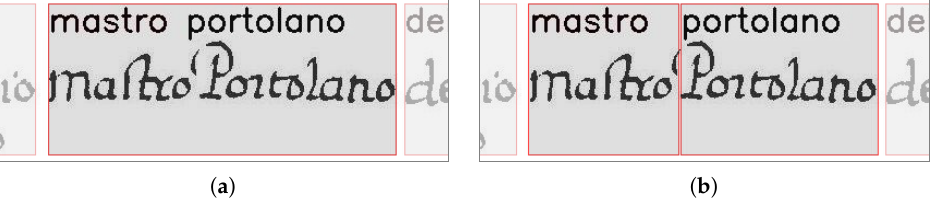
Figure 8. Example of correction of under-segmentation errors: ( a ) the results of the original algorithm show that the alignment assigned a single box to the transcription of the two words “mastro Por- tolano”; ( b ) the results of the modified algorithm show that it was able to split the bounding boxes and assign them to the two